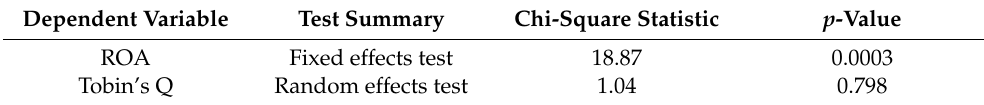
Table 5. Hausman Test Results.